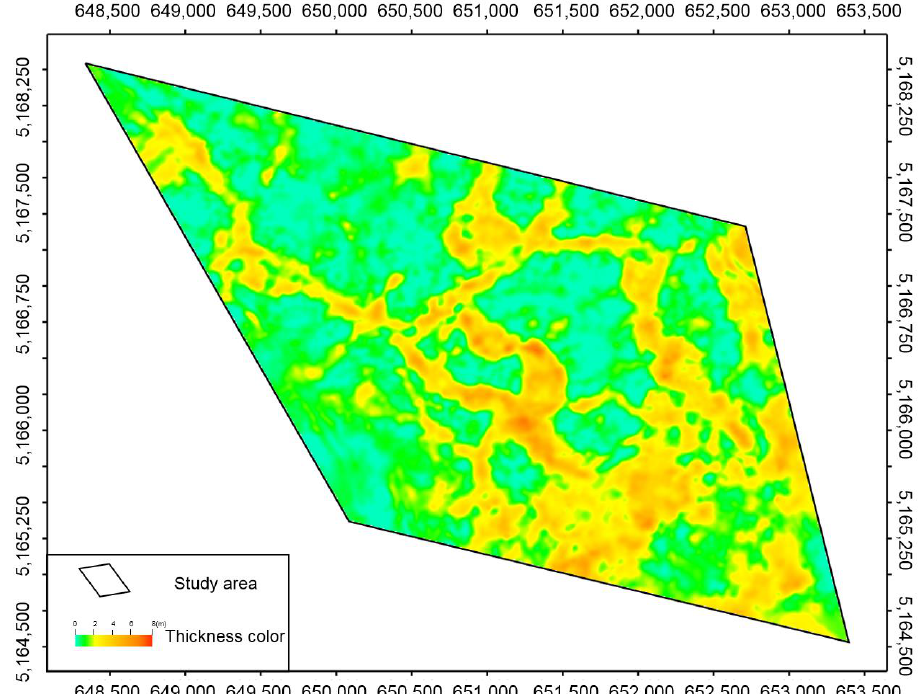
Figure 8. Sand thickness prediction map of G I 2